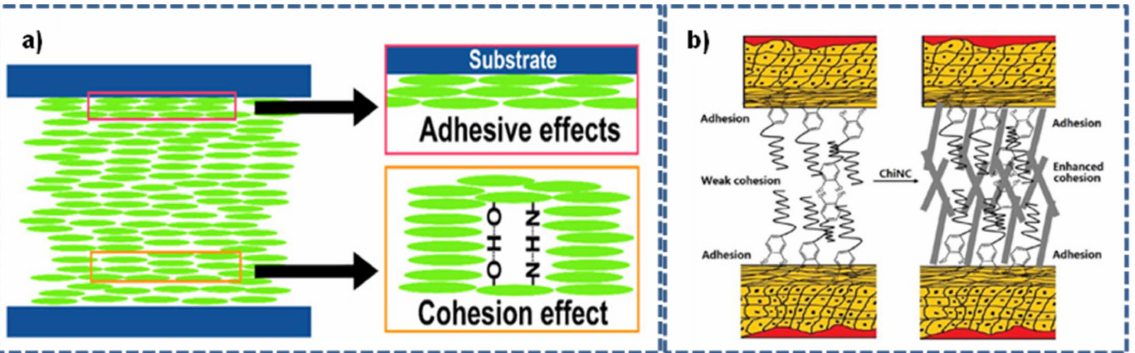
Figure 6. Schematic illustrations of the proposed mechanism of ( a ) adhesive effect of ChNCs (adapted with permission from Ref. [112]. Copyright 2021 American Chemical Society) and ( b ) of improved ad- hesion caused by incorporation of ChNCs on citrate-based tissue adhesive (adapted with permission from Ref. [113]. Copyright 2018